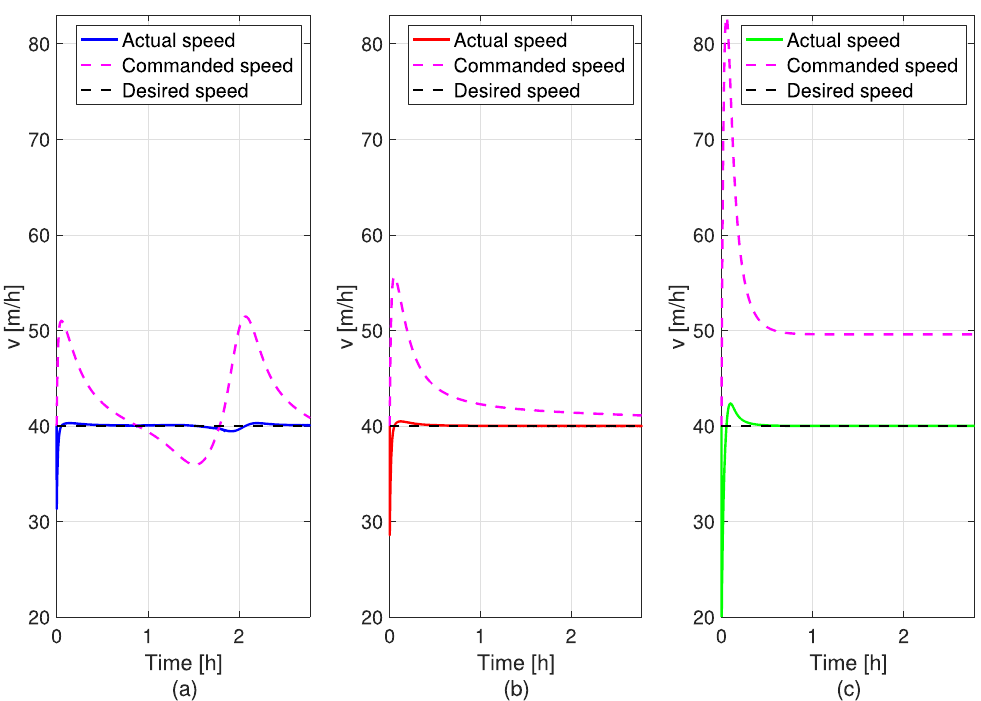
Figure 7. Rover’s trajectories in the 3D space on a 20° slope with constant steering angle 𝛿 = 4° and adaptive speed 𝑉̅ .